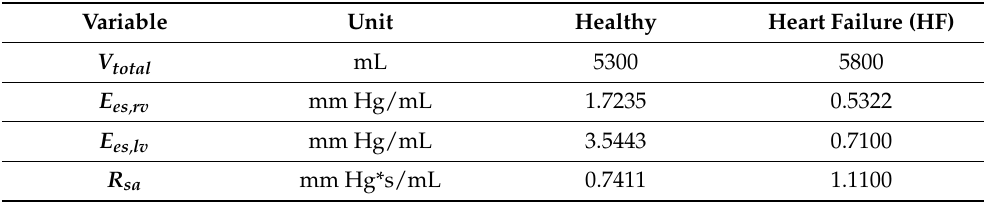
Table 1. CVS model parameters used to simulate heart failure